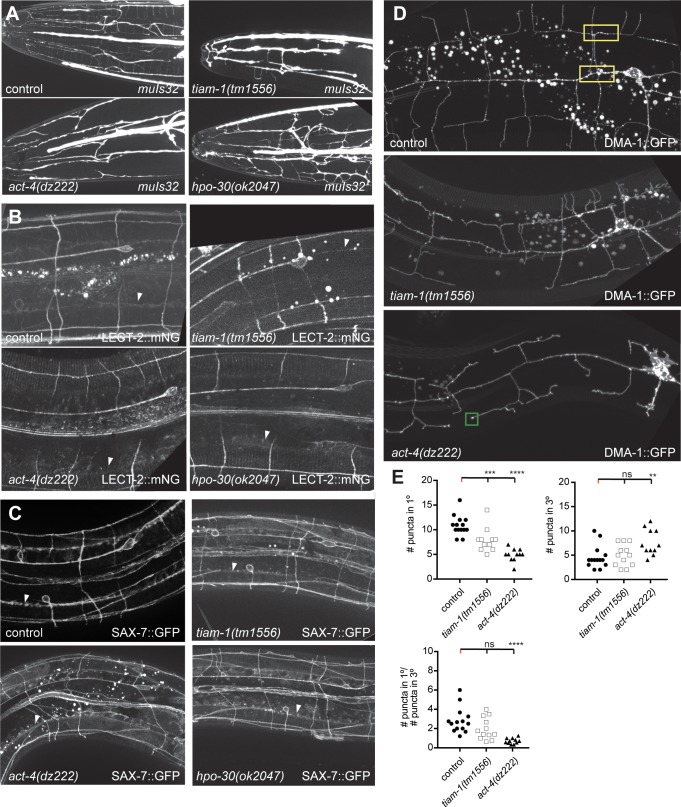
Effects of hpo-30/Claudin, tiam-1/GEF and act-4/Actin on localization of LECT-2:mNG, SAX-7::GFP and DMA-1::GFP.(A) Fluorescent images of animals expressing GFP in FLP neurons (muIs32 [Pmec-7::GFP]) in the indicated genotypes. Anterior is to the left and scale bars indicate 20 µm. (B – D) Fluorescent images of animals expressing a LECT-2::mNeonGreen fusion at endogenous levels (a functional knock in (lect-2(dz249) [lect-2::mNG^3xFlag] (Díaz-Balzac et al., 2016)) (B), a functional fosmid-based SAX-7::GFP reporter (ddIs290) (C), and a functional DMA-1::GFP reporter (D) (Liu and Shen, 2011). Arrowheads indicate the localization of LECT-2::mNG or SAX-7::GFP in a stripe at edge of the lateral hypodermis, where hypodermis and muscle abut. The control image (B) is identical to Figure 4B and shown for comparison only. A green box indicated enrichment of DMA-1::GFP at the tip of dendrites of act-4(dz222) mutant animals. (E) Quantification of DMA-1::GFP puncta in the genotypes indicated. n = 14 for control, n = 12 for tiam-1(tm1556), and n = 11 for act-4(dz222). For raw data see Figure 1— source data 1. Statistical significance is indicated as Data are represented as mean ±SEM. Statistical comparisons were performed using one-sided ANOVA with the Tukey correction. Statistical significance is indicated (ns: not significant, **p<0.05, ***p<0.005, ****p<0.0005).